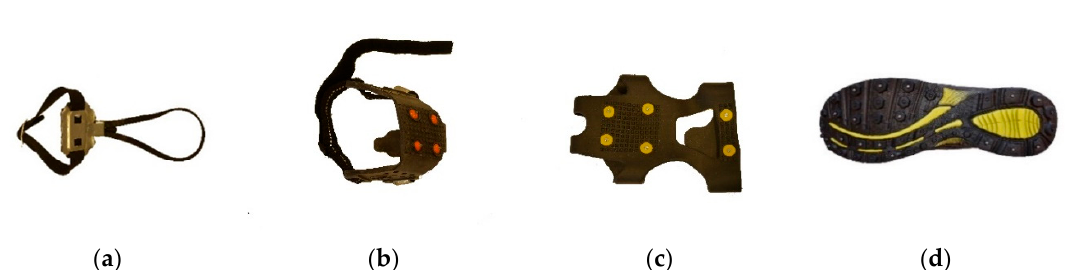
Figure 1. Examples of the main type models: ( a ) Forefoot device, #1; ( b ) heel device, # 4; ( c ) whole-foot device, #13; and ( d ) shoe with built in studs, #19.